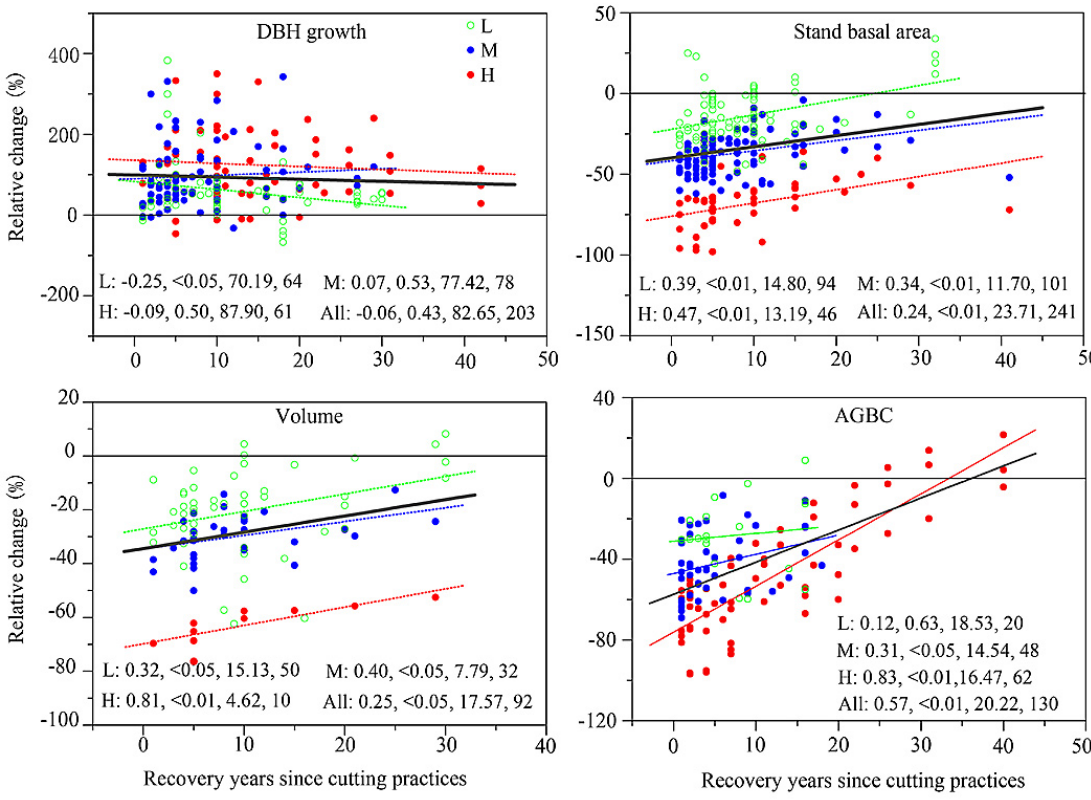
Fig. 5. The relative changes (%) along the RY gradient, where the observations were grouped into L (green circle), M (blue circle), and H (red circle) cutting levels. The dotted lines represent the linear fit curves of the cutting under L, M, and H intensities with corresponding colors, and the bold black line indicates the linear fit curve of all cutting (All). The R , P , SE and N of each linear regression analysis are shown at the bottom of each figure panel. Five observations that are larger than 400% were not shown in the figure panel of DBH